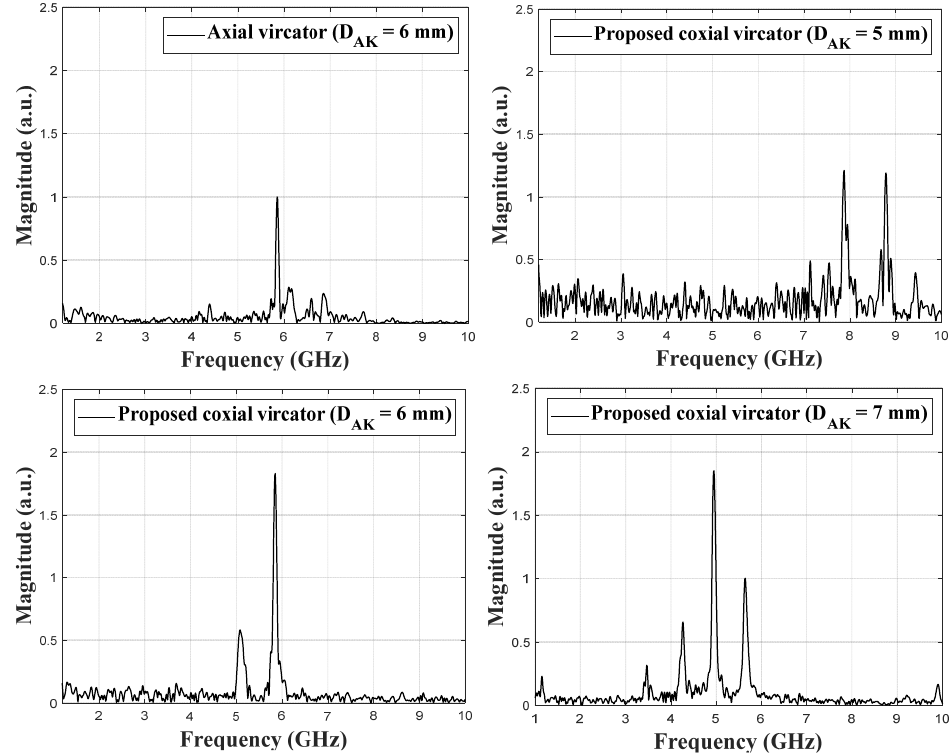
Figure 8. Frequency spectrum of the axial vircator and proposed coaxial vircator.